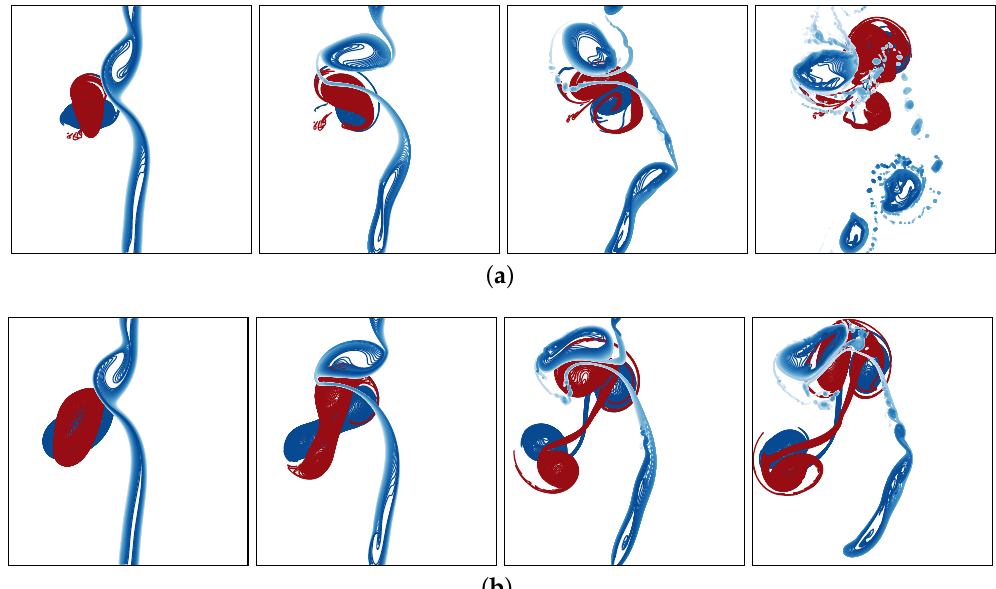
Figure 11. Cases 3.1 ( a ) and 3.2 ( b ): effect of increasing the width-to-height aspect ratio r / h v of the heton. In case 3.1, r / h v = 1 and r / a = 2, while in case 3.2, r / h v = 1.5 and r / a = 3, representing a doubling and a tripling relative to the default case 1. Top view of the flow showing contours of buoyancy and PV. In (a), the times shown are t = 14, 20, 26 and 40, while in (b), the times shown are t = 10, 14, 20 and 24.